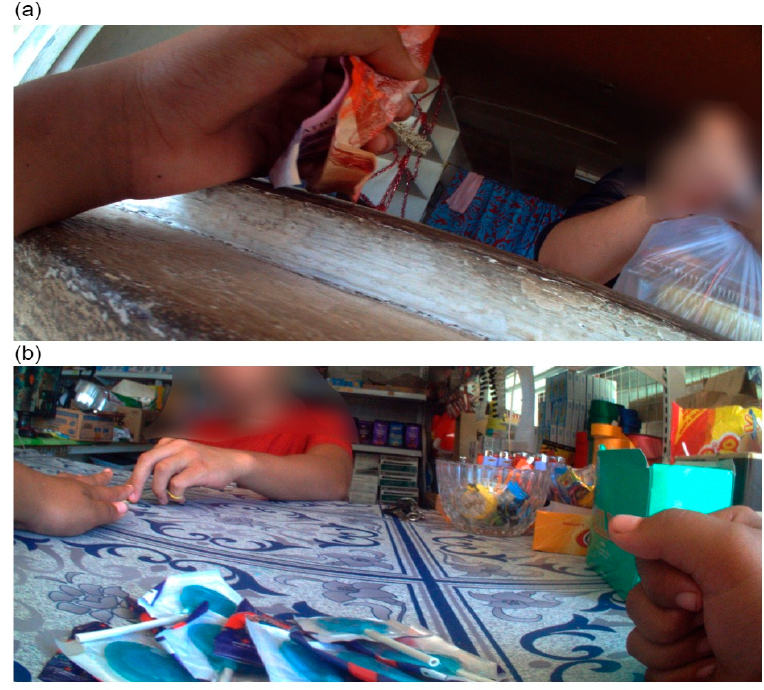
Figure 5. ( a ) and ( b ) are examples of product purchases by the participant.